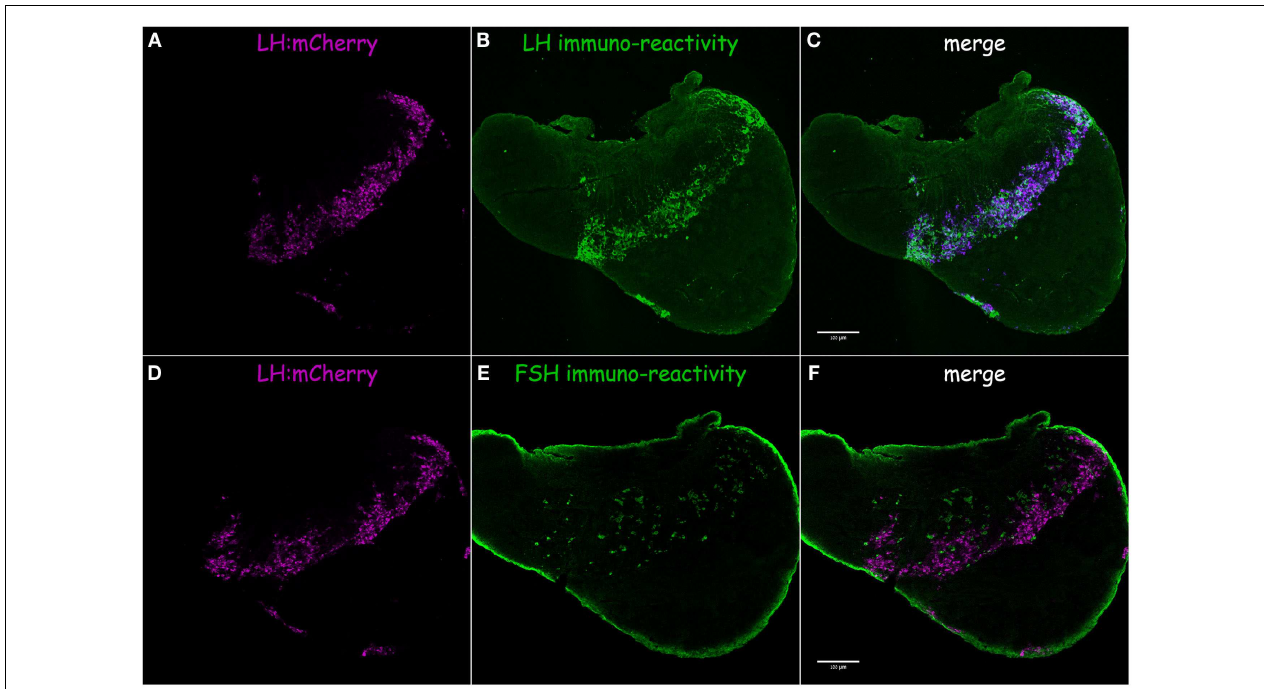
(A) LH:mCherry in the adult pituitary. (B) LH β immunoreactivity. (C) Merge of A and B shows high level of colocalization of both signals. (D) LH:mCherry in the adult pituitary. (E) FSH β immunoreactivity. (F) Merge of D and E shows FSH is expressed in a different subset of cells.